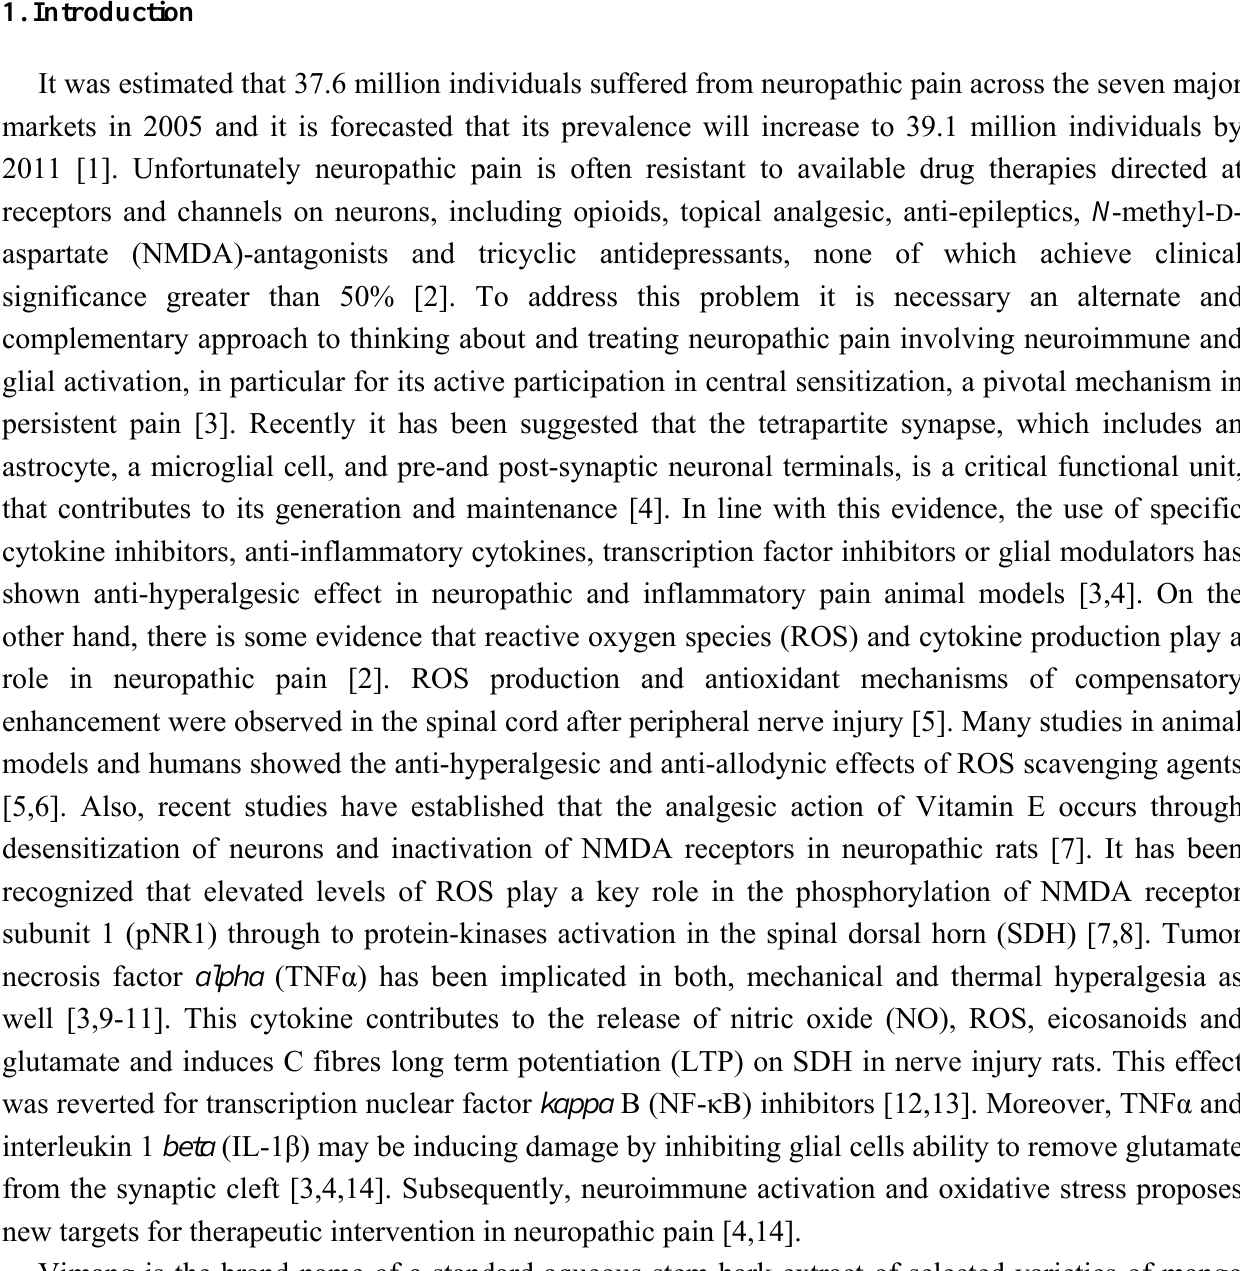
, phospholipase A ; AA, arachidonic 2 2